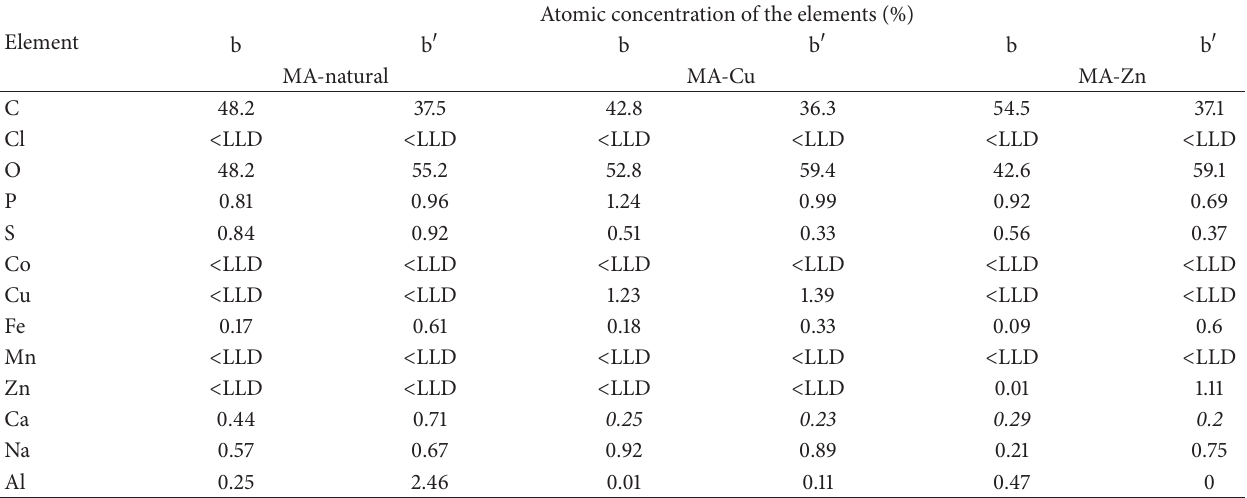
Table 2: Atomic concentration of the elements (%) on the surface (b) and in the cross section (b 󸀠 ) of macroalga Vaucheria sessilis after bioaccumulation. Atomic concentration of the elements (%) Element b 󸀠 MA-natural MA-Cu MA-Zn